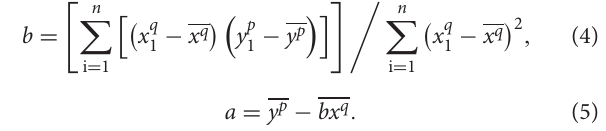
represents the first image to be returned. q band n cells of corresponding figure points with the same name. D dn value, ε 1 conforms to standard normal distribution i = 1 , 2 , . . . , n